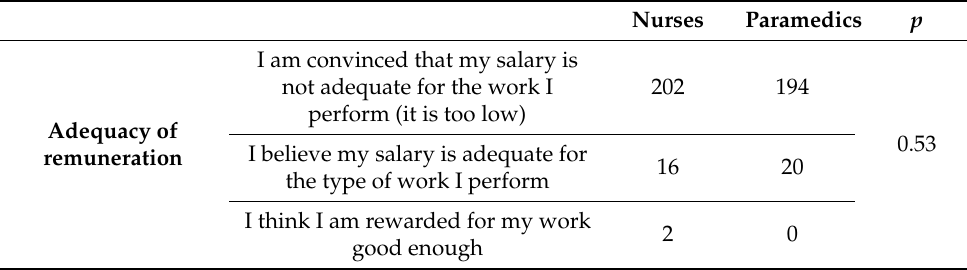
Table 11. The correlation between salary adequacy of nurses and